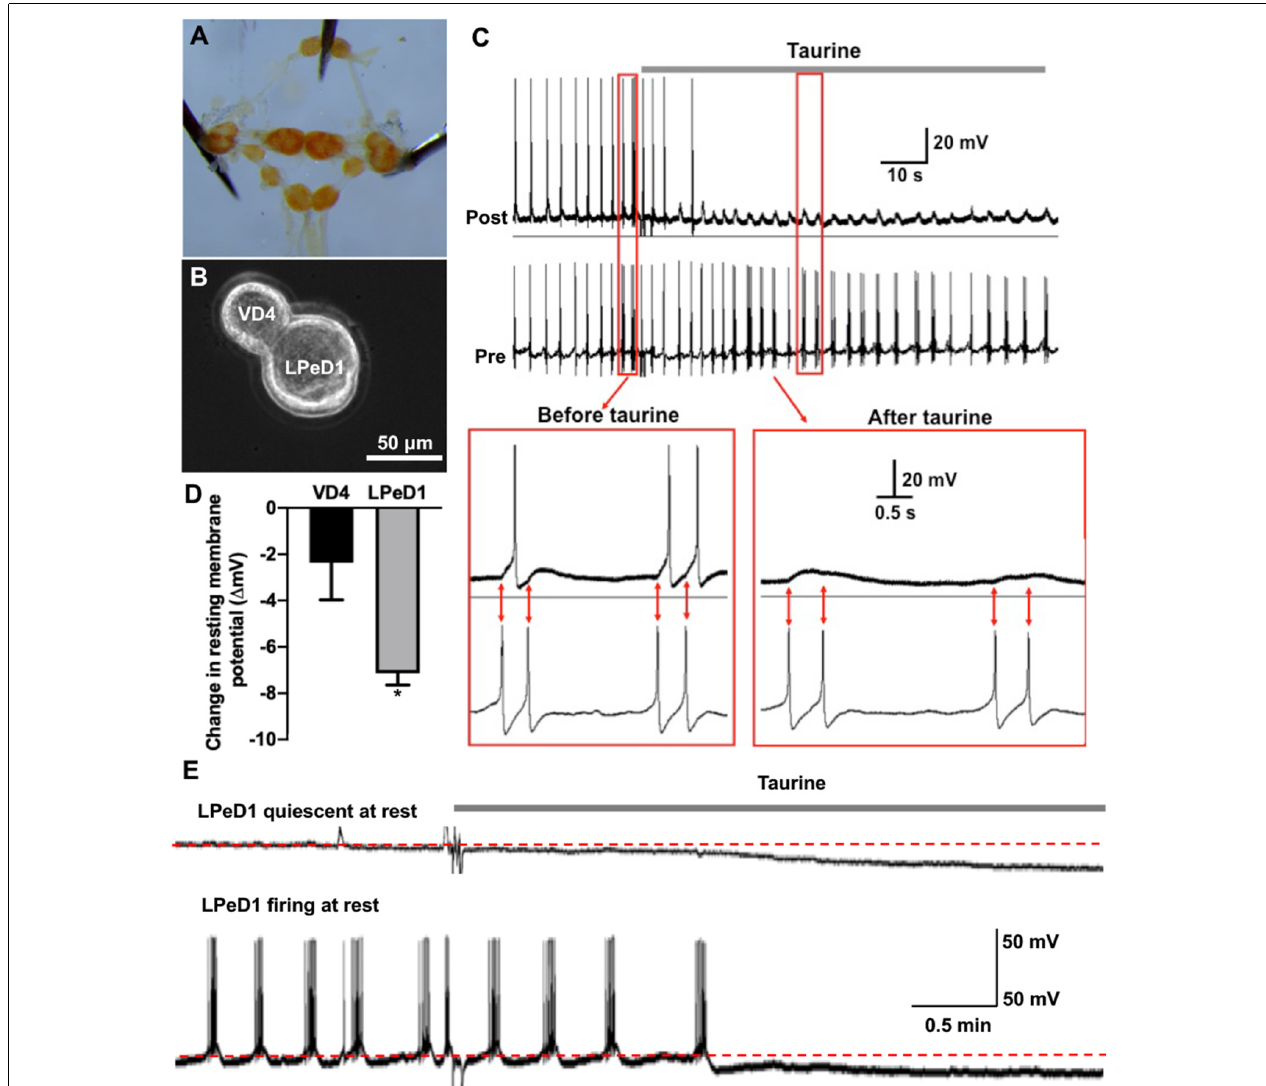
FIGURE 5 | Acute exposure of Lymnaea central neurons to taurine alters the excitability of two synapse-forming neurons. (A) L. stagnalis central ring ganglion was dissected. (B) To examine whether acute exposure to a high concentration of taurine affects neuronal excitability and/or synaptic transmission, well defined L. stagnalis pre- and postsynaptic VD4-LPeD1 neuronal pairs were cultured and allowed to form synapses ( n = 4). (C) Intracellular recordings revealed that presynaptic action potentials elicited electrical activities in postsynaptic neurons, and these were quieted after exposure to taurine at 2.5 mM. Interestingly, the postsynaptic potentials (PSPs) remained throughout the presence of taurine, indicating that taurine can selectively modulate neural excitability change while allowing the synaptic transmission to occur between two synaptic neurons. (D) At rest, taurine caused a significantly larger hyperpolarizing membrane potential change ( ∆ mV) in LPeD1 neurons (7.14 ± 0.5 mV) than that in VD4 neurons (2.37 ± 1.6 mV; student t- test, p = 0.049; n = 3). Negative direction and Y-axis values indicate a hyperpolarizing action of taurine on the resting membrane potentials of VD4 and LPeD1. (E) The hyperpolarization in LPeD1 neurons occurred in either quiescent or actively firing LPeD1 cells. The dotted lines indicate basal membrane potential levels. *Indicates a significance level of p <